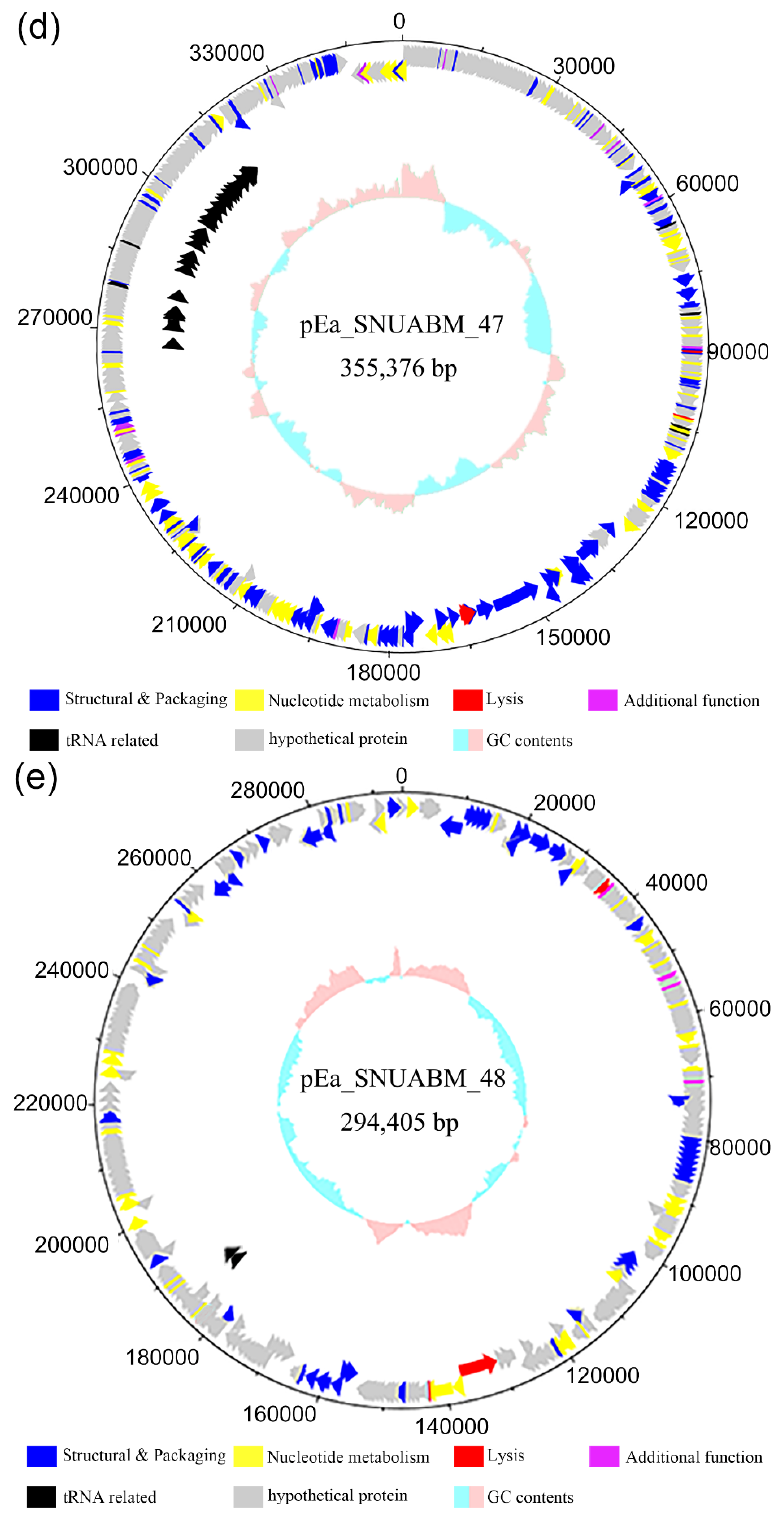
Figure 6. Genome map of Erwinia phages ( a ) ϕ 27, ( b ) ϕ 31, ( c ) ϕ 32, ( d ) ϕ 47, and ( e ) ϕ 48. The open reading frames were functionally assorted into six groups of proteins related to: structure and packaging (blue), nucleotide metabolism (yellow), lysis (red), and additional functions (purple), as well as tRNA proteins or tRNA-related proteins (black), and hypothetical proteins (gray). Scale is base pair (bp).